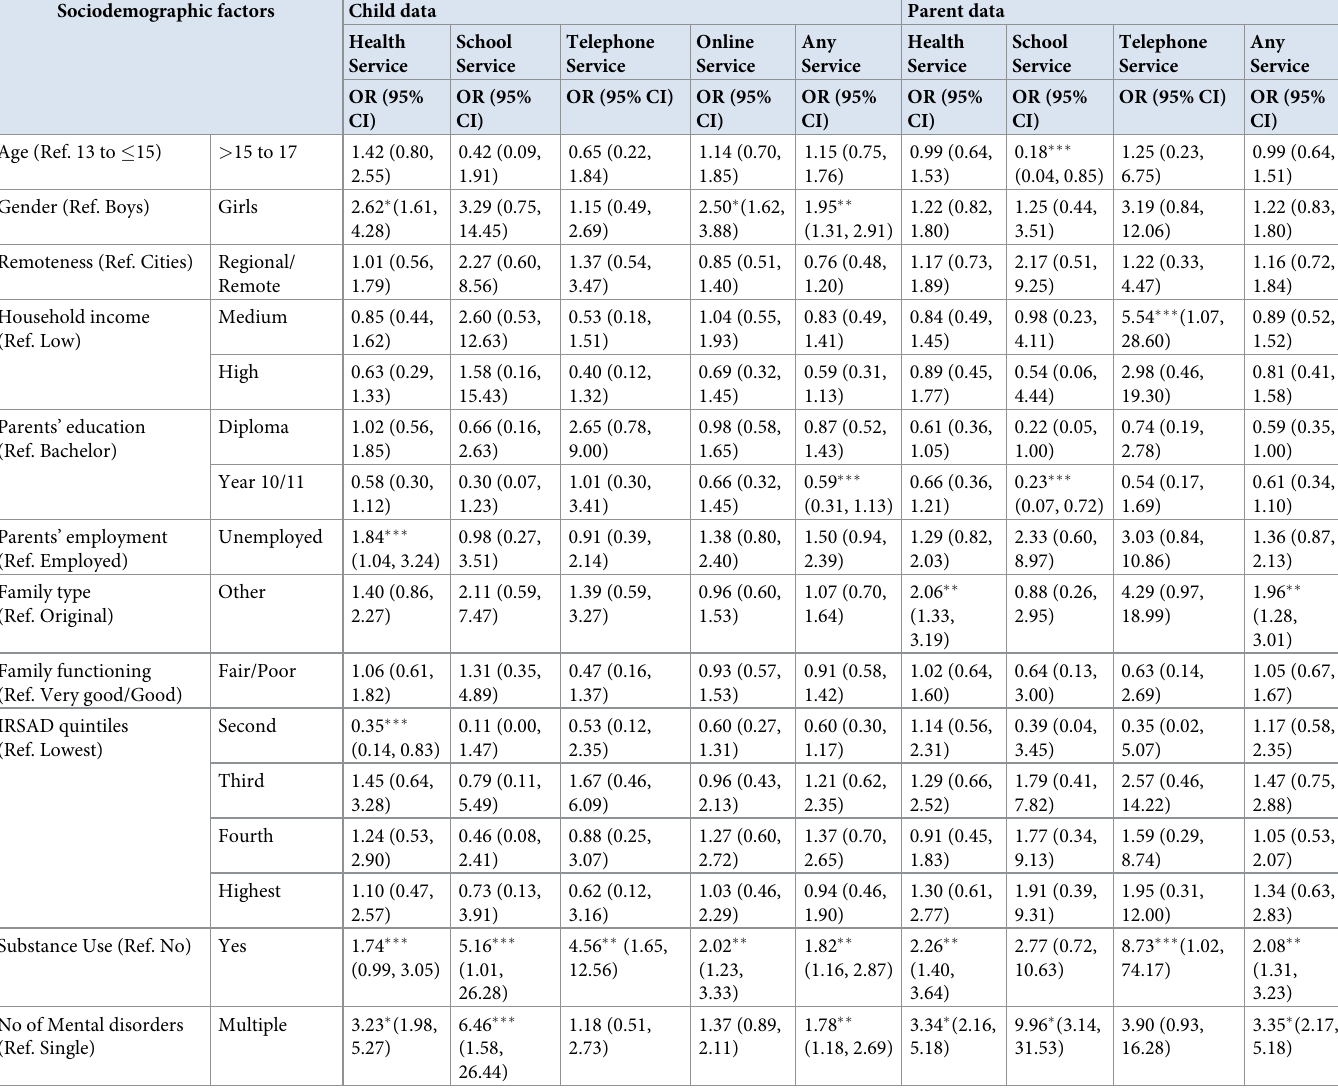
Table 3. Factors associated with mental health service uses in sub-sample I (binary regression). Sociodemographic factors